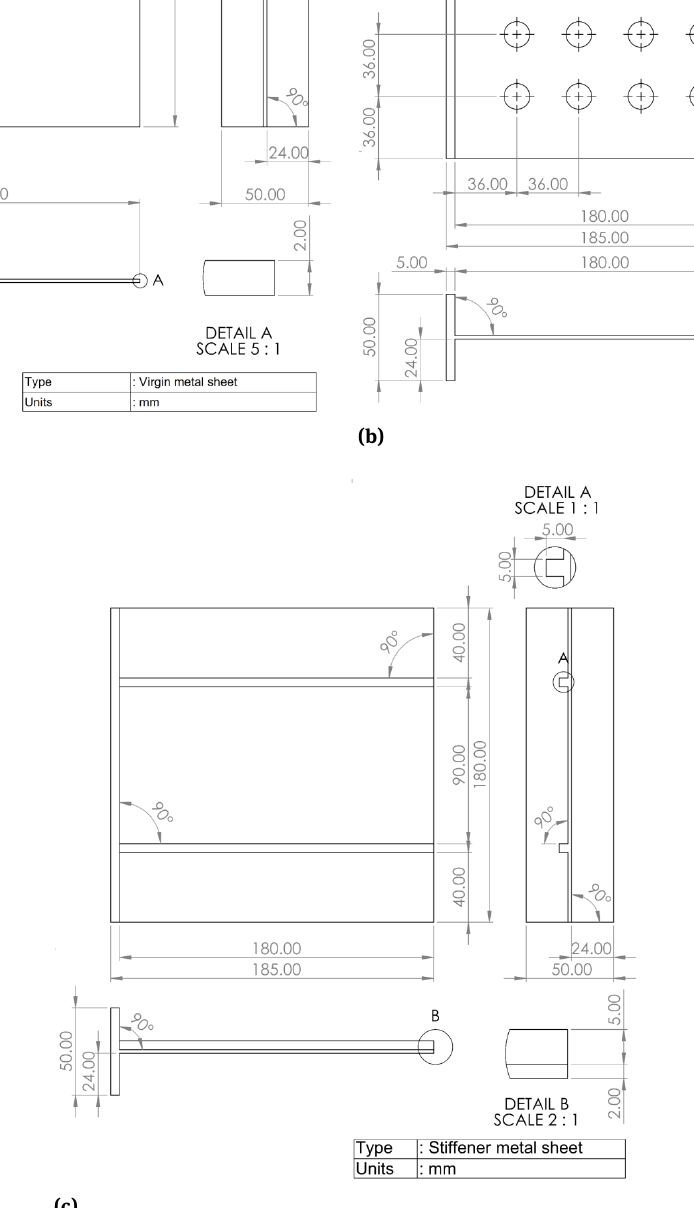
Figure 4: Technical drawing of models and sketch application: ( a ) virgin metal sheet; ( b ) hole metal sheet; ( c ) stiffener metal